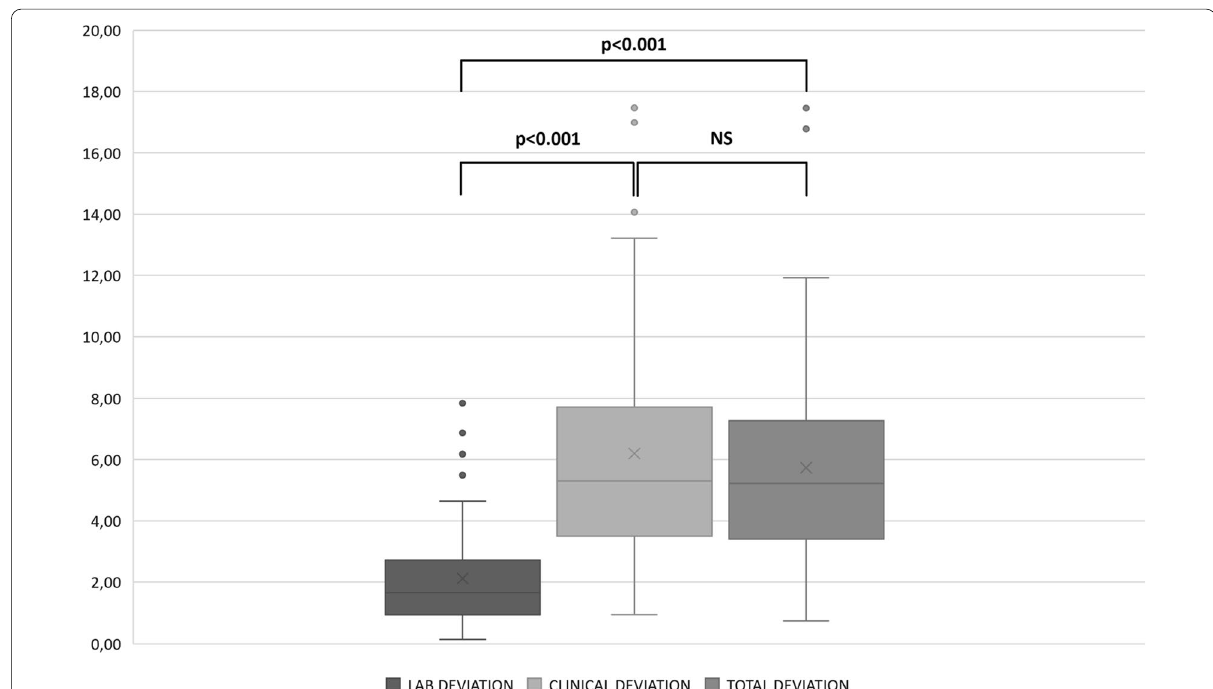
Fig.4 boxplots of the distribution of deviations for the laboratory step, the clinical step, and the total step, and the significance of the differences among the steps ( p <